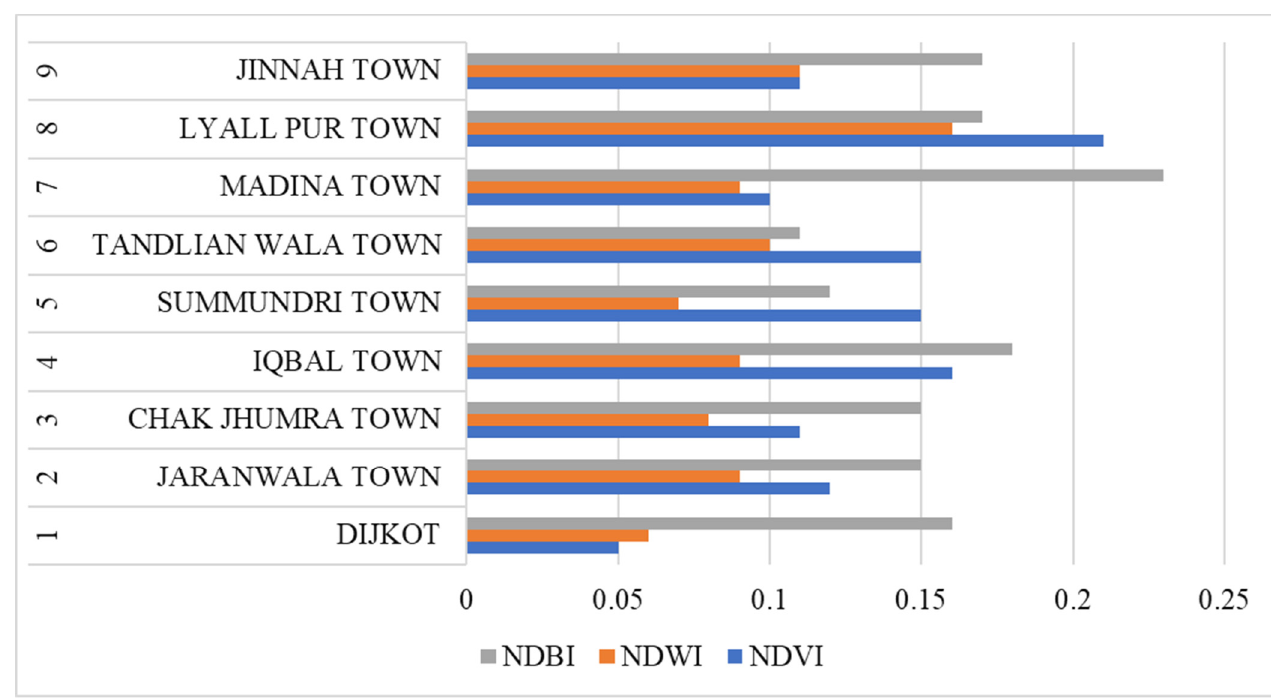
Figure 8. Standard deviation of the RS indices.